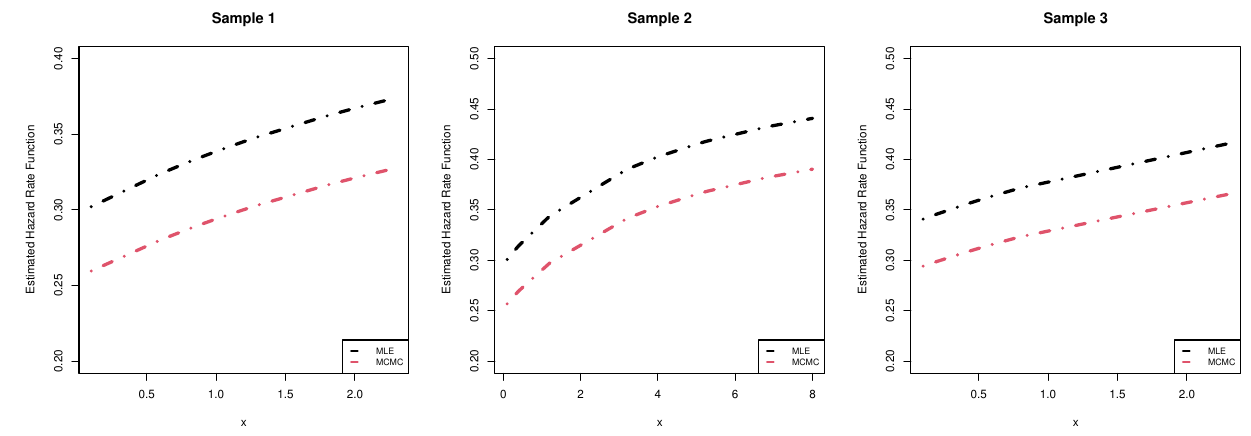
Figure 15. Estimated hazard rate plots from the vinyl chloride data.